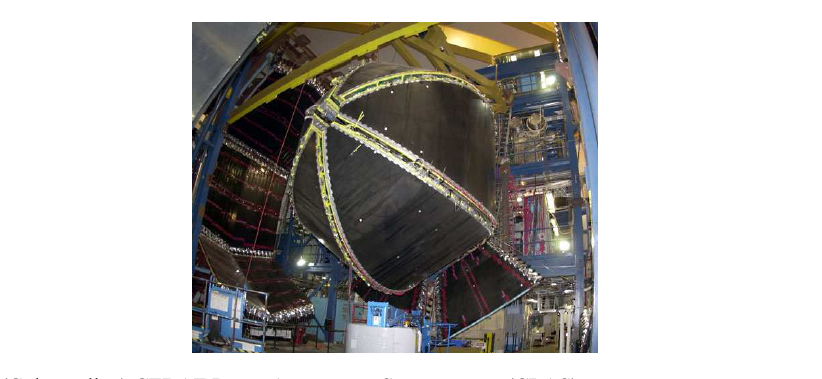
Fig. 1. (Color online) CEBAF Large Acceptance Spectrometer (CLAS).